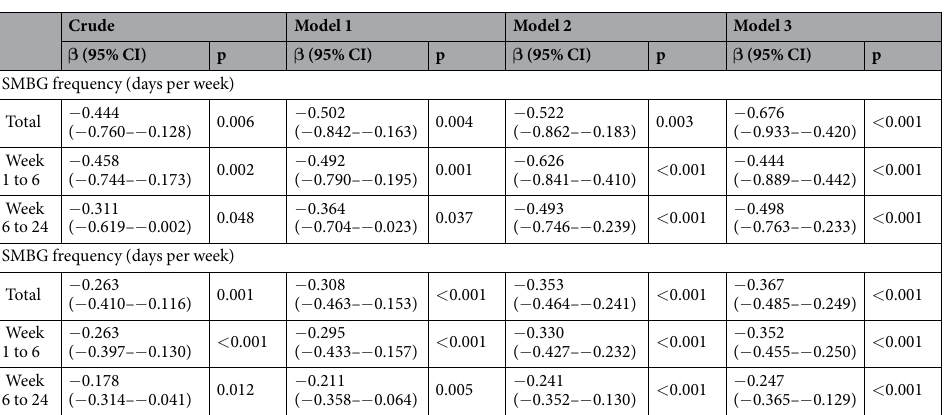
Table 4. Association between change in HbA1c at 6 months and SMBG frequency in the telemonitoring group. Model 1 is adjusted for age and sex. Model 2 is adjusted for age, sex, and baseline self-efficacy scale. Model 3 is adjusted for age, sex, self-efficacy scale, BMI, SBP, LDL, and HbA1c at